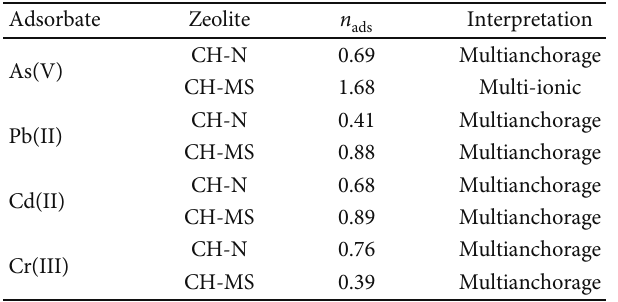
Table 5: Calculated steric parameters for the adsorption of